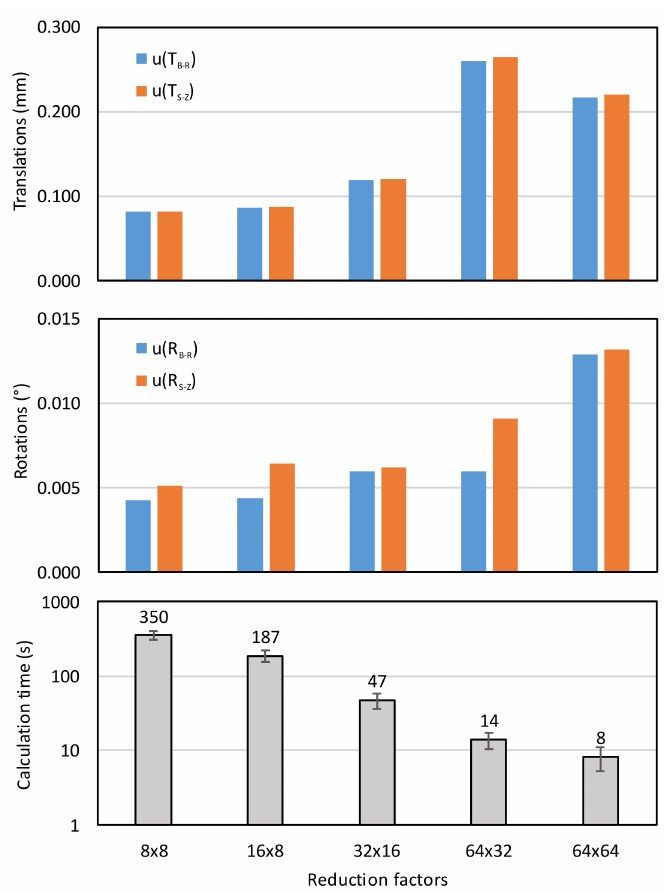
Figure 10. Influence of point-cloud reduction factors on measured uncertainty of extrinsic translations (upper diagram) and rotations (middle diagram) and on calculation time (bottom